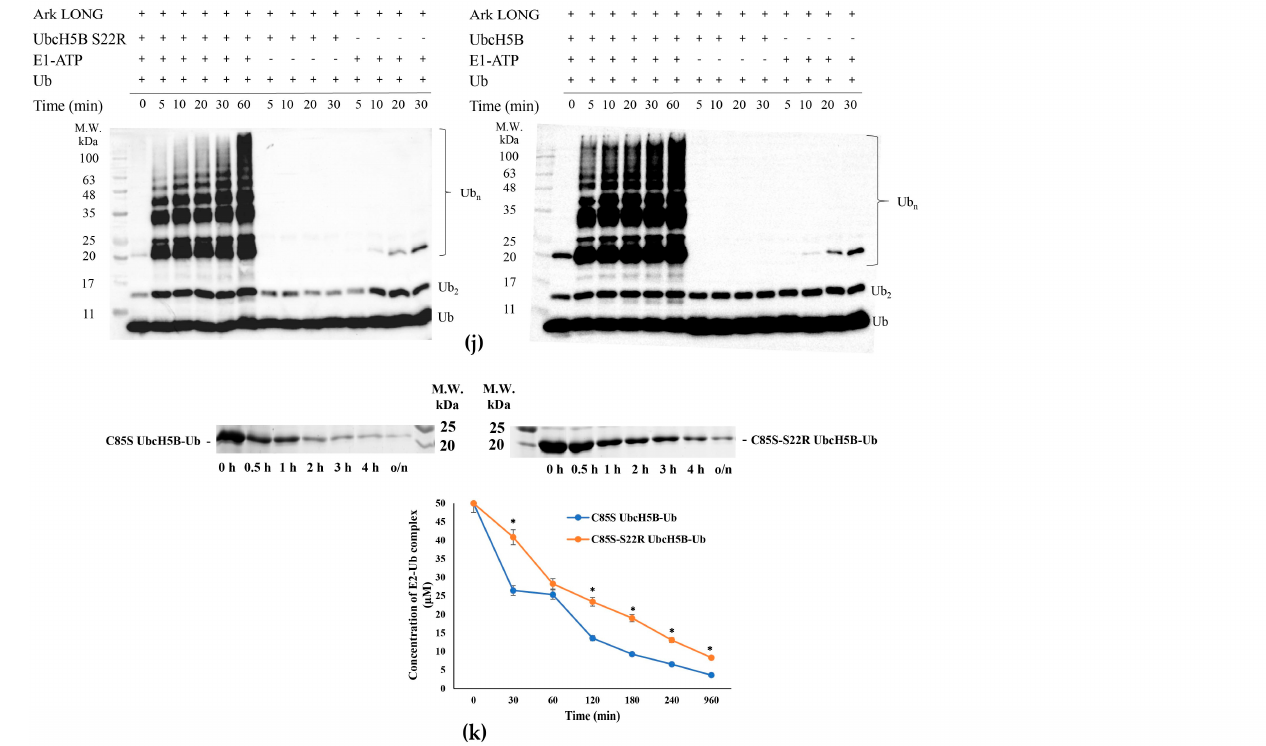
Figure 4. Implication of the Ub B binding in Arkadia-mediated ubiquitylation. ( a ) Diagram of the total CSPs measured at a 1:2 molar ratio for 15 N UbcH5B S22R/ 14 N Ark RING, *: represents disappeared residues, +: represents residues with no information. ( b ) Diagram of the total CSPs measured at q 1:2 molar ratio for 15 N Ark RING/ 14 N UbcH5B S22R. ( c ) Ark RING mapping (PDBid: 2KIZ) after the addition of UbcH5B S22R (residues that disappeared during the interaction are colored red, whereas residues that exhibited ‘fast exchange’ interaction are colored coral). ( d ) Diagram of the total CSPs measured at a 1:2.75 molar ratio for 15 N UbcH5B S22R/ 14 N Ub. ( e ) Diagram of the total CSPs measured at a 1:2.75 molar ratio for 15 N wt UbcH5B/ 14 N Ub. ( f ) UbcH5B mapping (PDBid: 2ESK) after the addition of Ub. ( g ) Diagram of the total CSPs measured at a 1:2.25 molar ratio for 15 N Ub/ 14 N UbcH5B S22R. ( h ) Diagram of the total CSPs measured at a 1:2.25 molar ratio for 15 N Ub/ 14 N wt UbcH5B. ( i ) Ub mapping (PDBid: 1D3Z) after the addition of wt UbcH5B. ( j ) In vitro auto-ubiquitylation assays of Ark LONG using UbcH5B S22R ( left ) and wt UbcH5B ( right ). ( k ) ( Top ), oxyester hydrolysis assays showing the disappearance of C85S UbcH5B-Ub and C85S S22R UbcH5B-Ub in the presence of Ark LONG, over time. ( Bottom ), densitometry quantification from gels (bars indicate the range of experimental duplicates, * indicates statistically significant difference, p value ≤ 0.05). The uncropped WB images can be seen in File